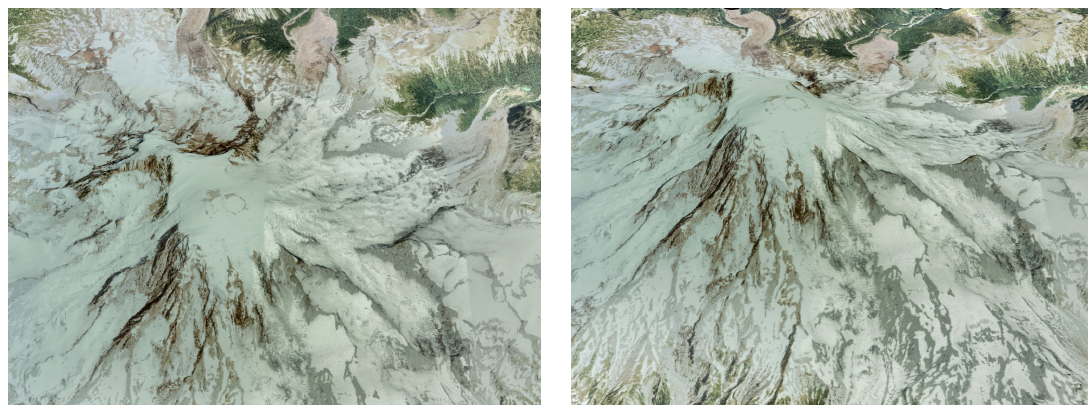
Figure 8. Example of Earth Viewer